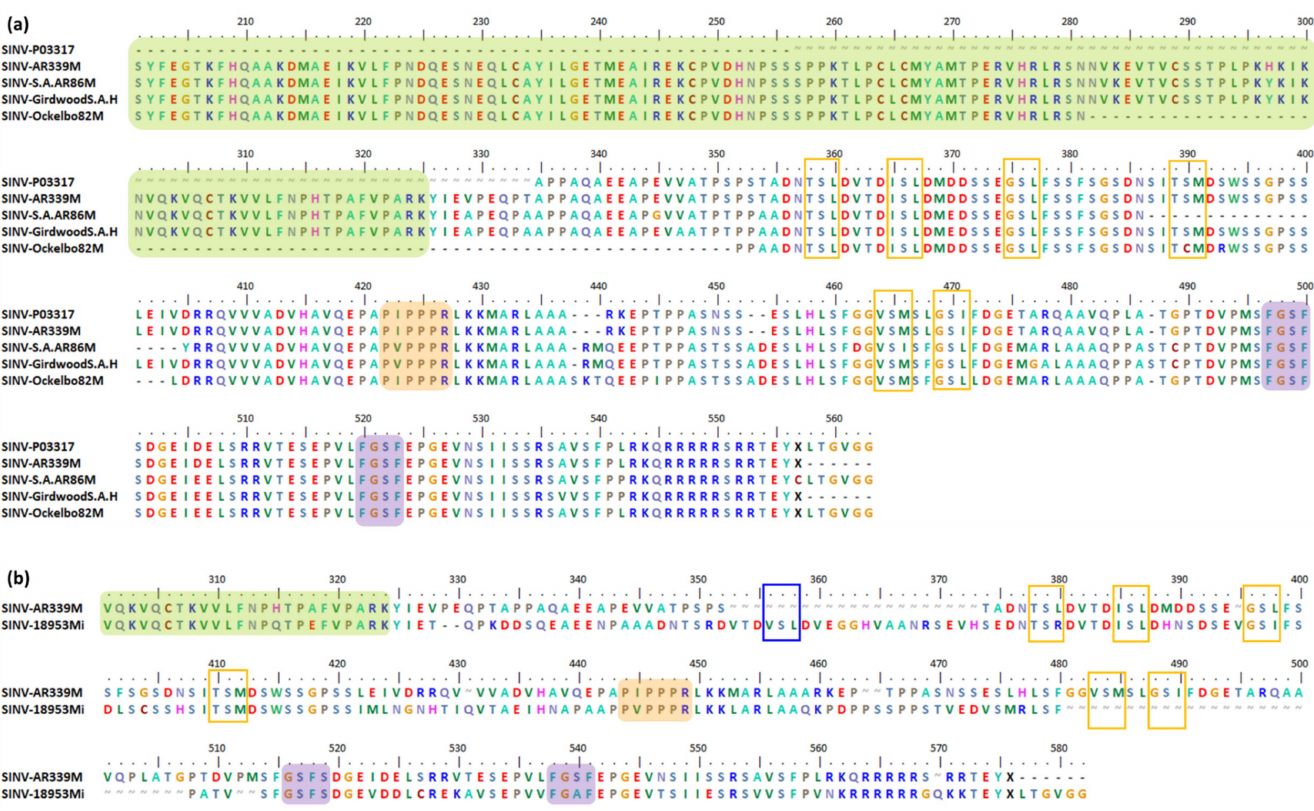
Figure 4. Important motifs and mutation events in SINV nsP3 HVD. The HVD starts at position 325. It has a P-rich region at position 422–427 ( a ) or 444–449 ( b ) (peach), and two FGDF-like motifs at positions 497–500 and 520–523 ( a ) or 516–519 and 538–541 ( b ) (purple). In ( a ), the Ockelbo82 has a 70 aa deletion at position 282–351, from AUD (green) to HVD (white). Meanwhile, S.A.AR86 and Ockelbo82 have 18 and 3 aa deletions at positions 387–404 and 401–403, respectively, which overlap at 401–403. There are 3 and 2 aa insertions in Ockelbo82 and both S.A.AR and Girdwood S.A at positions 438–440 and 439–440, respectively. At position 458–459, Ockelbo82, S.A.AR, and Girdwood S.A have a 2 aa insertion, while at position 487, S.A.AR86 and Girdwood S.A have a small 1 aa insertion. In ( b ), the SINV SINV_AUS_1975_18953 is shown to have a 21 aa insertion and a 27 aa deletion at positions 353–373 and 481–507, respectively. There is also a conserved short motif, the VSL, at position 356–358 ( b ) (blue box), which is possibly inserted in SINV_AUS_1975_18953. A few predicted VSL motifs such as TS(L/R), ISL, GS(L/I), and (T/V)(S/C)(M/I) have been conserved/inserted/deleted/repeated in SINV strains as well ( a and b ) (orange